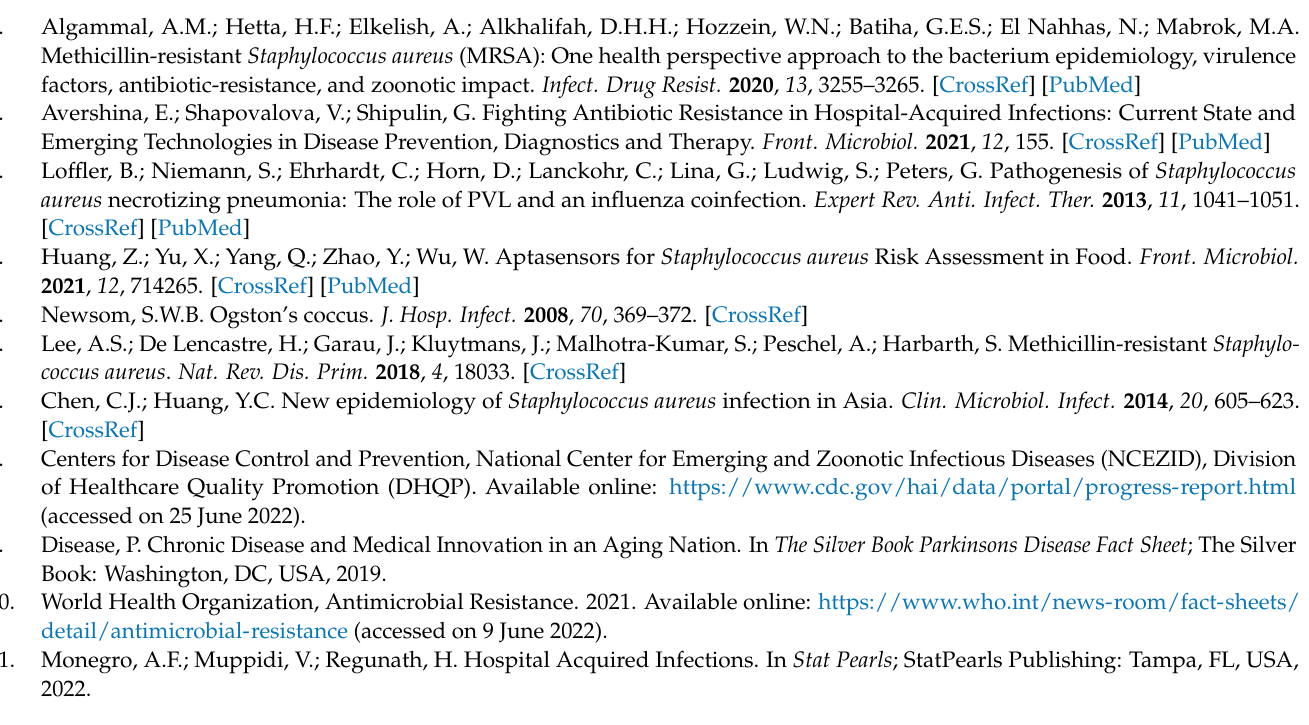
Figure S4a: 1 H-NMR spectrum of 5-(1 H -indol-3-yl)-4-pentyl-1,3-oxazole-2-carboxylic acid (Com- pound 1); Figure S4b: 13 C-NMR spectrum of 5-(1 H